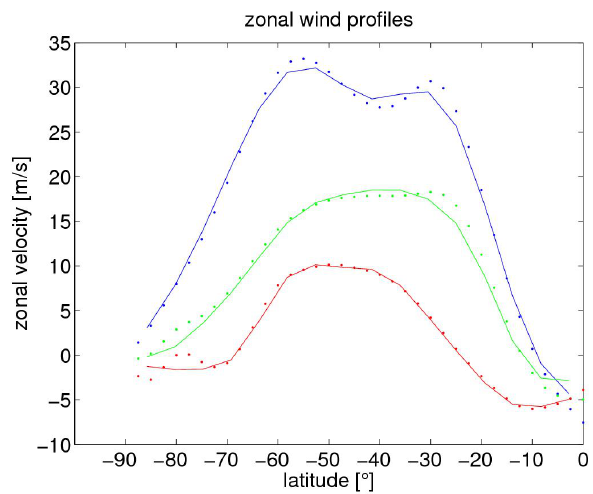
Fig. 3. Modelled (continuous) and observed (dotted) time-mean zonal wind profiles for the three model levels 833hPa (red), 500hPa (green) and 167hPa (blue) and corresponding vertical layers, re-